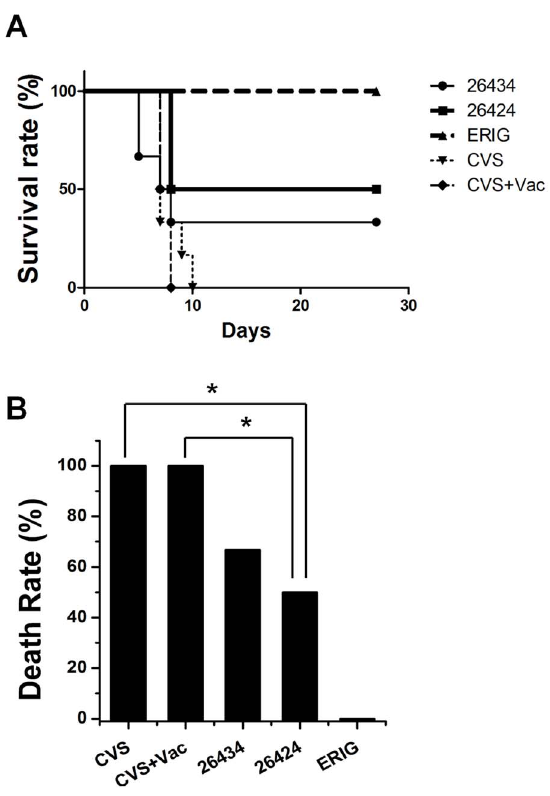
Figure 7. Invivo lethal challenge of rabies infection. (A) Kaplan– Meier survival curve for mice in post exposure prophylaxis with the sdAb pentamer constructs. Mice were challenged with 2500 LD 50 CVS- 24 strain of RABV mixed with 26424 (1.6 IU ml 2 1 ) and 26434 (0.2